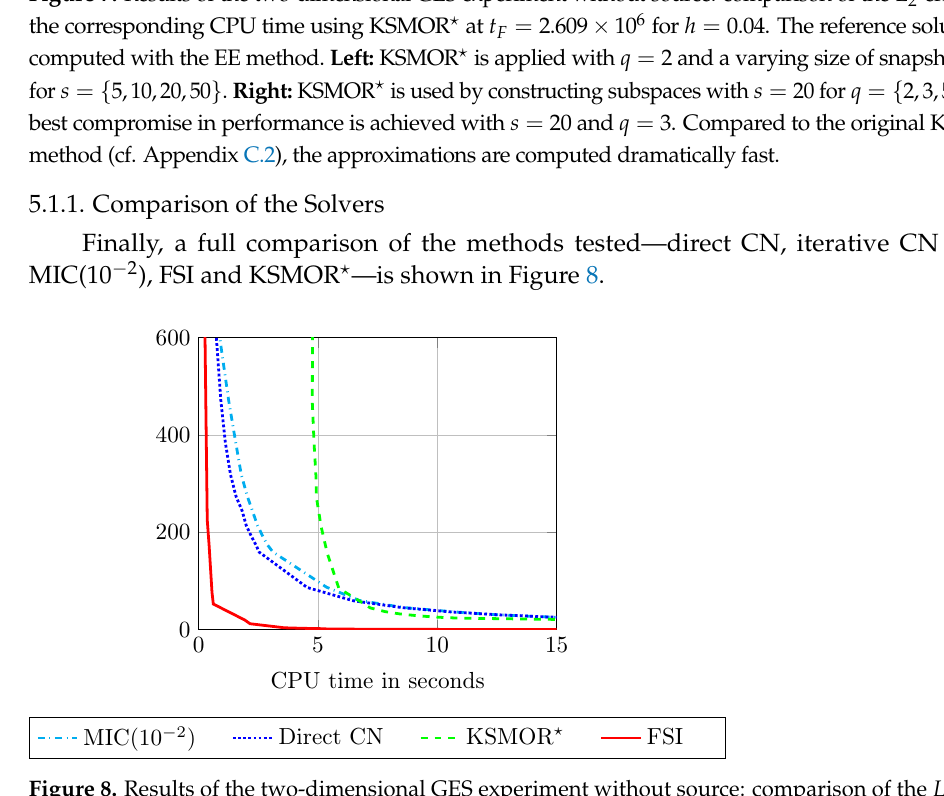
10 6 for h = 0.04. The reference solution is × 2,3,5 . The { }